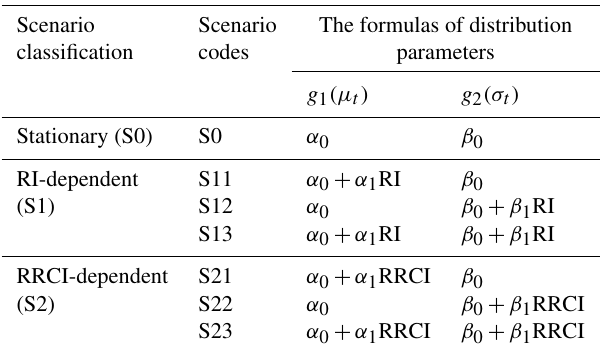
Table 2. Seven nonstationary scenarios for the formulas of the two distribution parameters (i.e., µ t and σ t ).